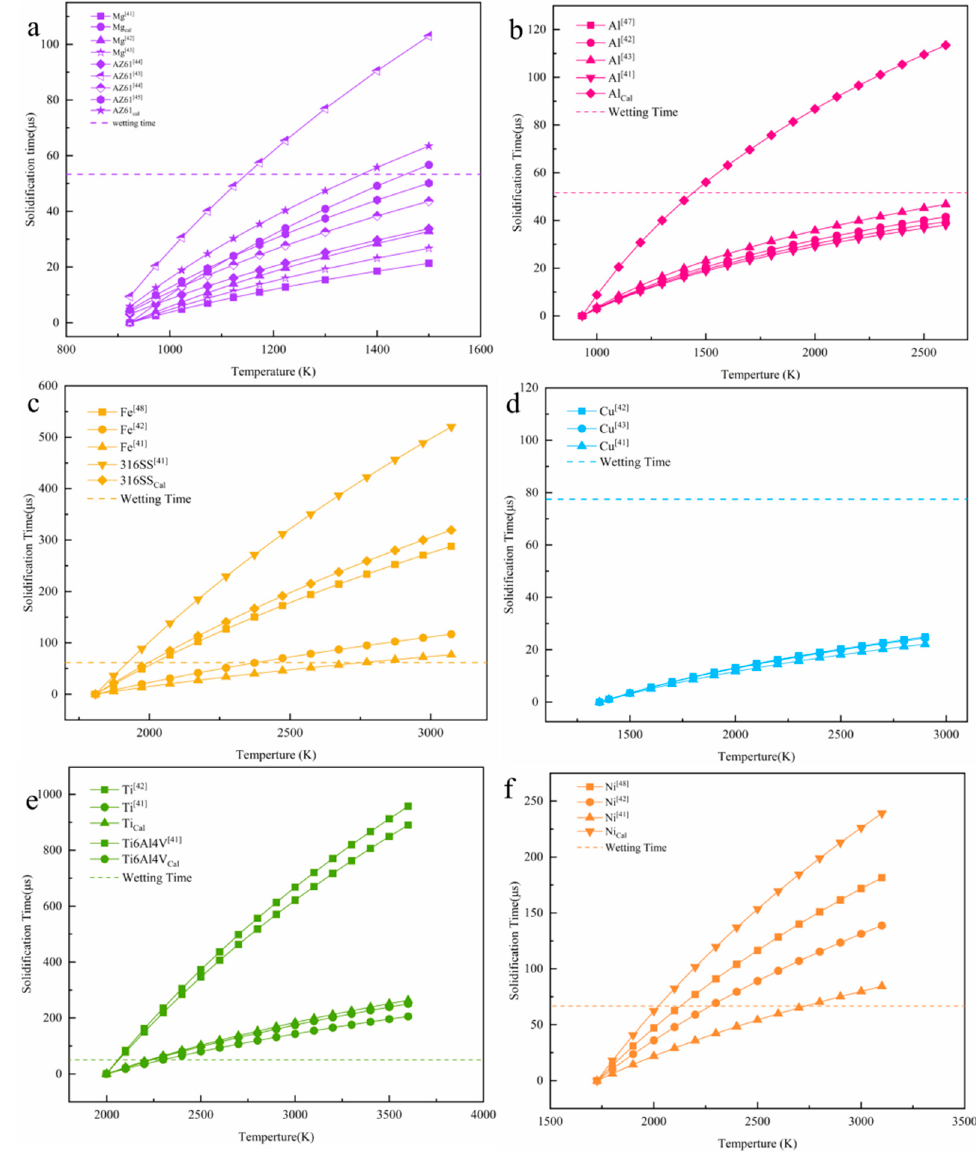
Figure 8. Calculation relationship between metal droplet temperature and solidification time of different metal melts ( a ) Mg; ( b ) Al; ( c ) Fe; ( d ) Cu; ( e ) Ti; and, ( f ) Ni. The dotted line in the Figure represents the calculated spreading time.